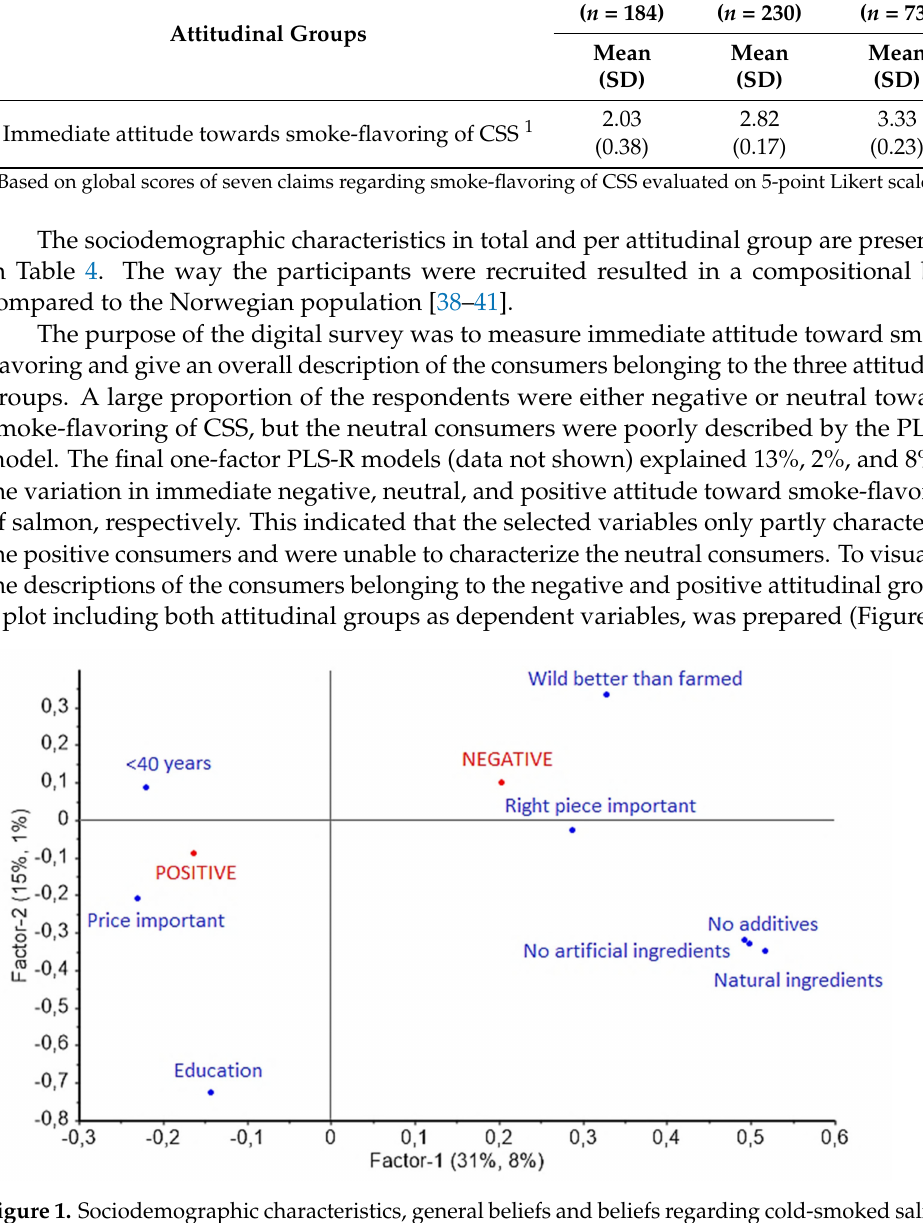
Figure 1. Sociodemographic characteristics, general beliefs and beliefs regarding cold-smoked salmon characterizing the negative and the positive attitudinal group in a PLS-R